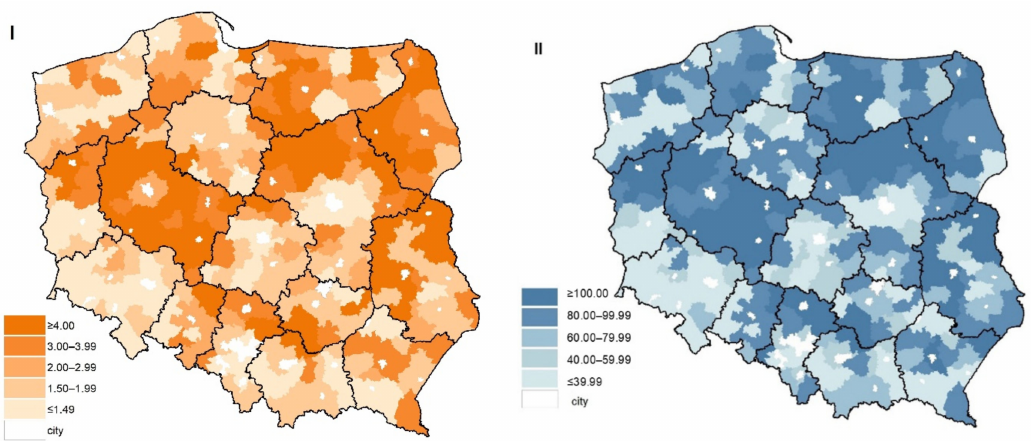
Figure 5. Number of applications implemented under both measures per 1000 inhabitants ( I ) and amount (EUR) from both activities per 1 inhabitant ( II ). Source: own study based on data from ARMA and LDB CSO,